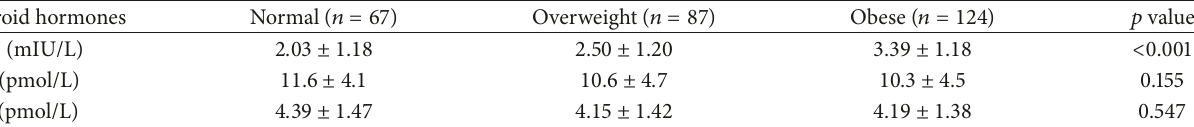
Table 3: Thyroid hormones serum levels (mean ± SD) according to participants’ body mass index.